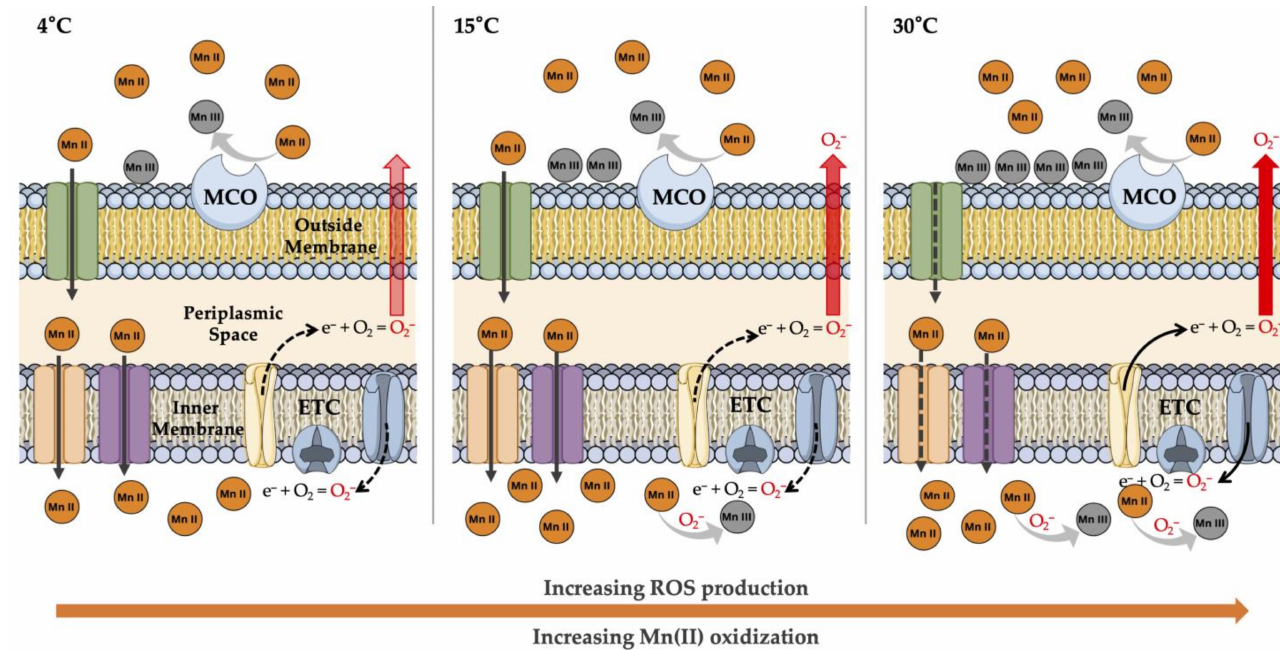
Figure 1. Schematic diagram of the hypothetical activity of ROS-mediated Mn(II) oxidation. Multicopper oxidases (MCO), the enzymatic oxidative pathway, generate constitutive Mn(II) oxidation outside the membrane and precipitate as Mn(III). At warming conditions (up to 4 ◦ C), electrons (e − ) are released (solid arrow) from the electron transport chain (ETC), reacting with O 2 , forming superoxide anion (O 2 − ). As temperature increases, the permeable Mn(II) by Mn transport is accumulated in intracellular milieu, inducing a toxic effect; thus, the Mn channels reduce the transport (dashed arrow). The ROS produced via ETC (inside) react with intracellular Mn(II) or are diffused through the membranes, reacting with Mn(II) in extracellular milieu and deposited as oxides. This mechanism could be an indirect mechanism of Mn(II) oxidation in a pathway unrelated to